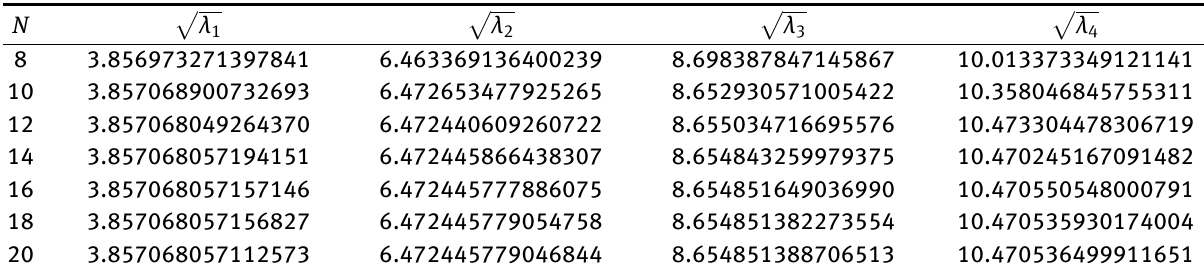
(︁ √ )︁ for CS case for different grid points λ Table 7: